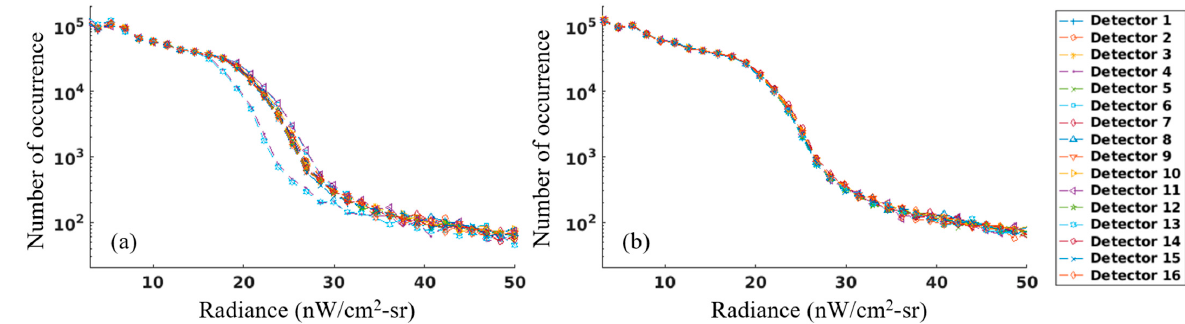
Figure 14. Histogram of the radiances of aggregation zone 21 of the NOAA-20 VIIRS DNB nighttime granules collected between 8:50 UTC and 9:10 UTC, October 24, 2018. ( a ) The nighttime imagery was created by the original NOAA-20 VIIRS DNB Gain Ratios LUT. ( b ) The nighttime imagery was created by the updated NOAA-20 VIIRS DNB Gain Ratios LUT.